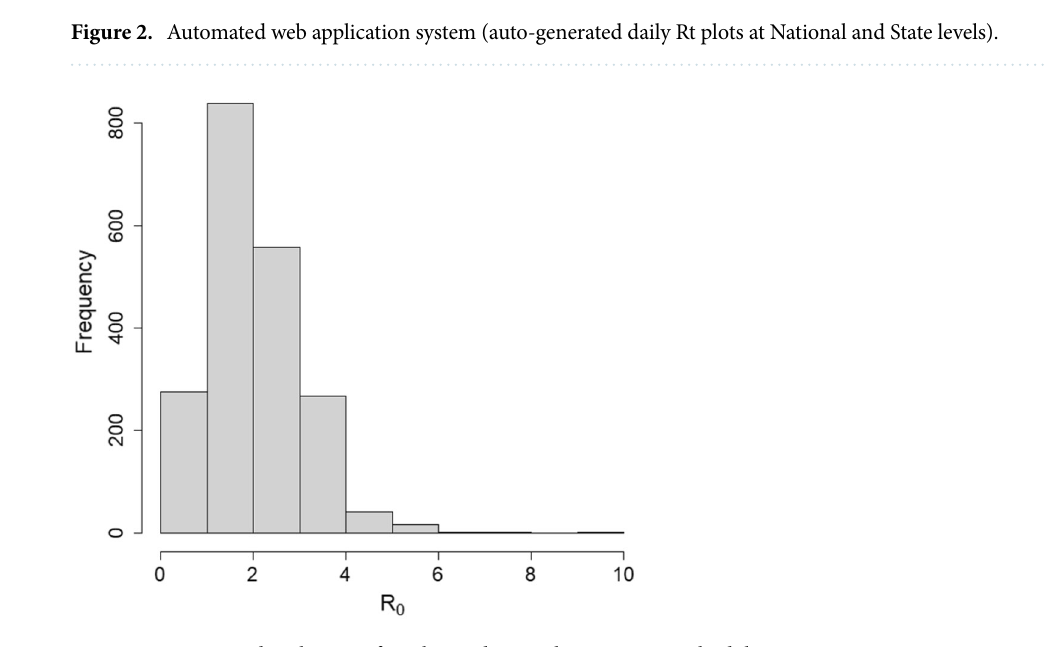
Figure 3. Posterior distribution of Rt obtained using the Bayesian